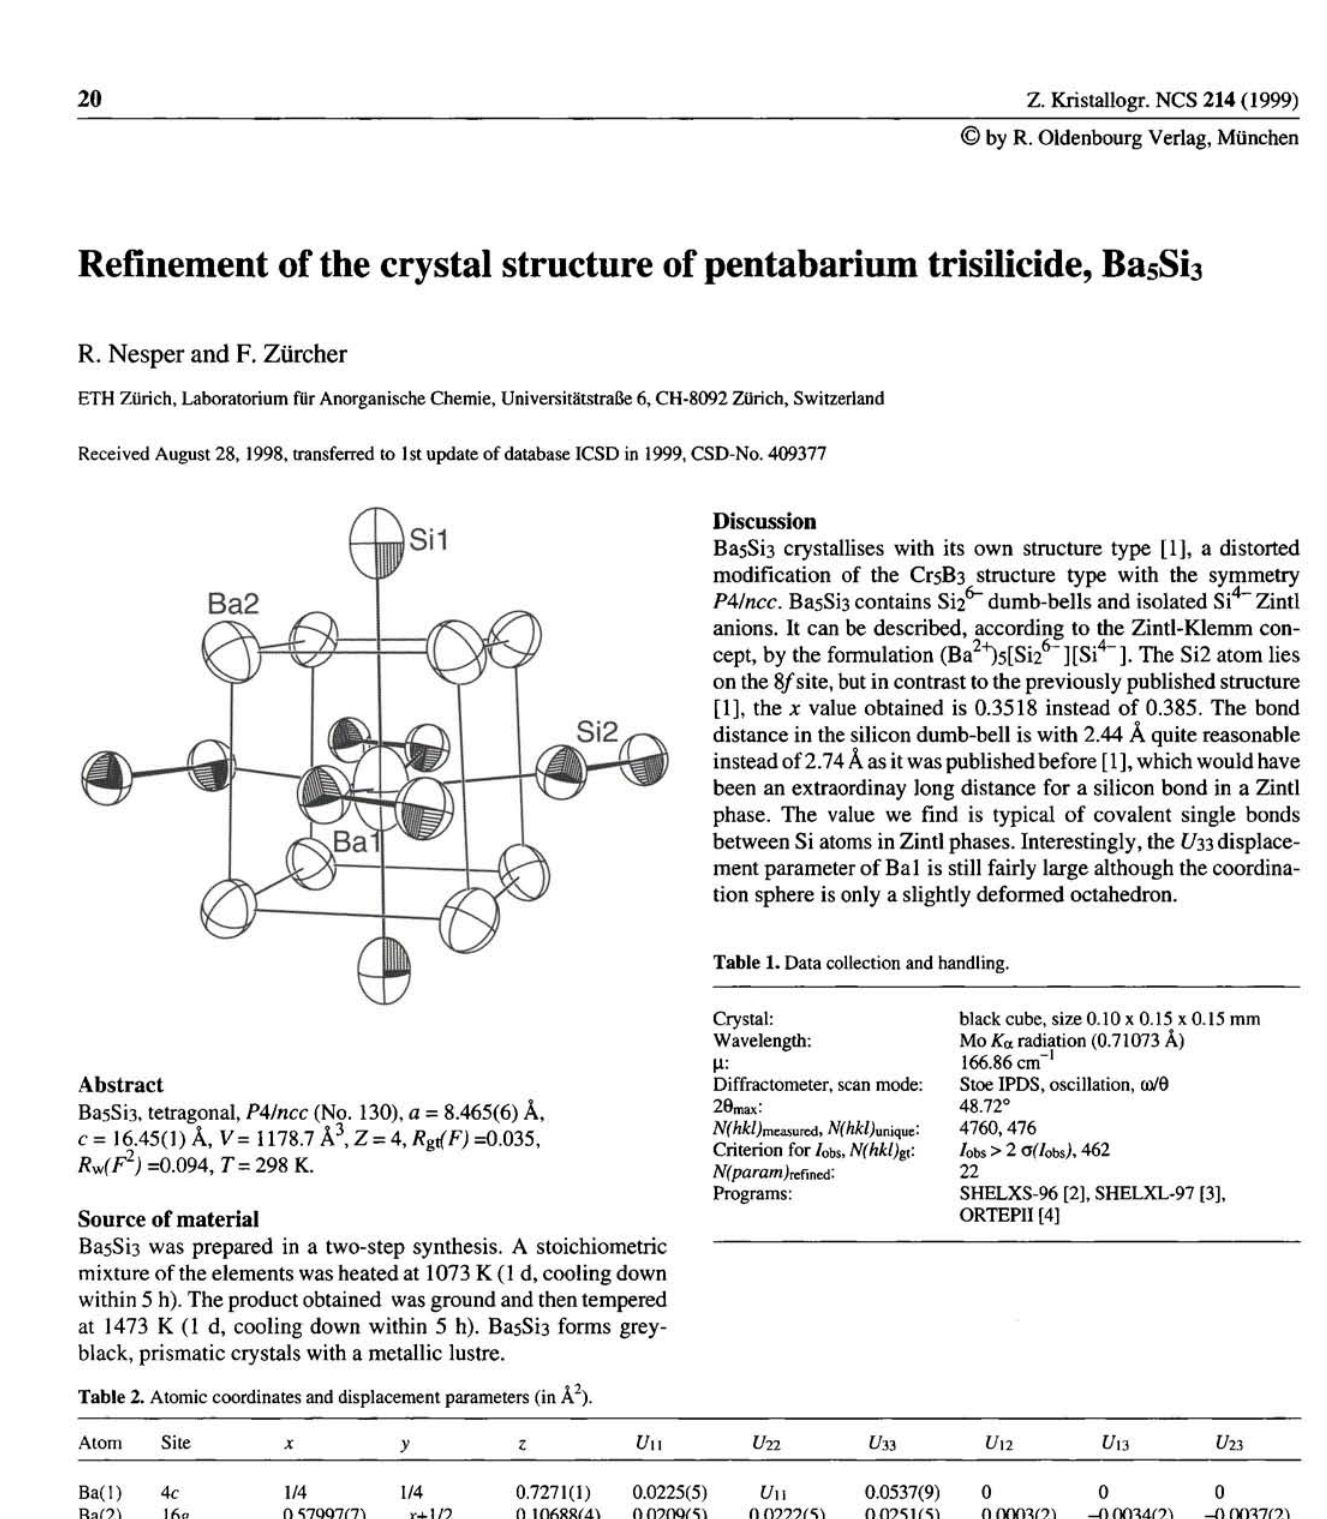
Table 2. Atomic coordinates and displacement parameters (in Â 2 ).